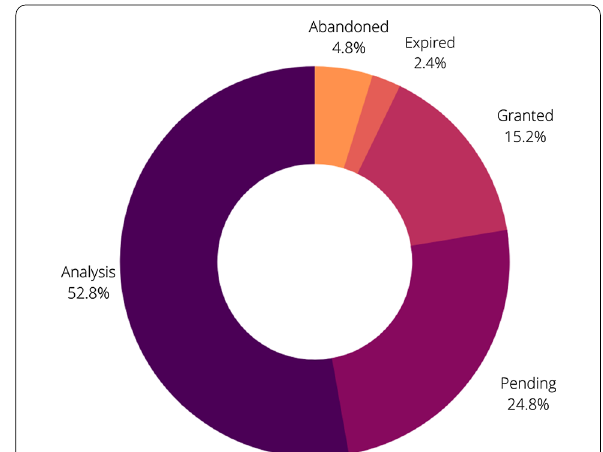
Fig. 4 Statuses of patents related to microalgae in agriculture according to patent office